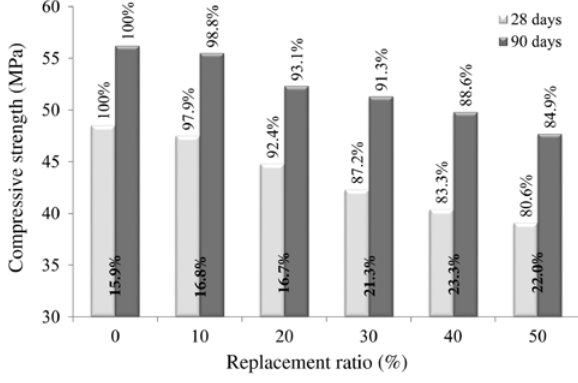
Figure 3: Abrasion losses of concrete series. Figure 4: Compressive strength of series